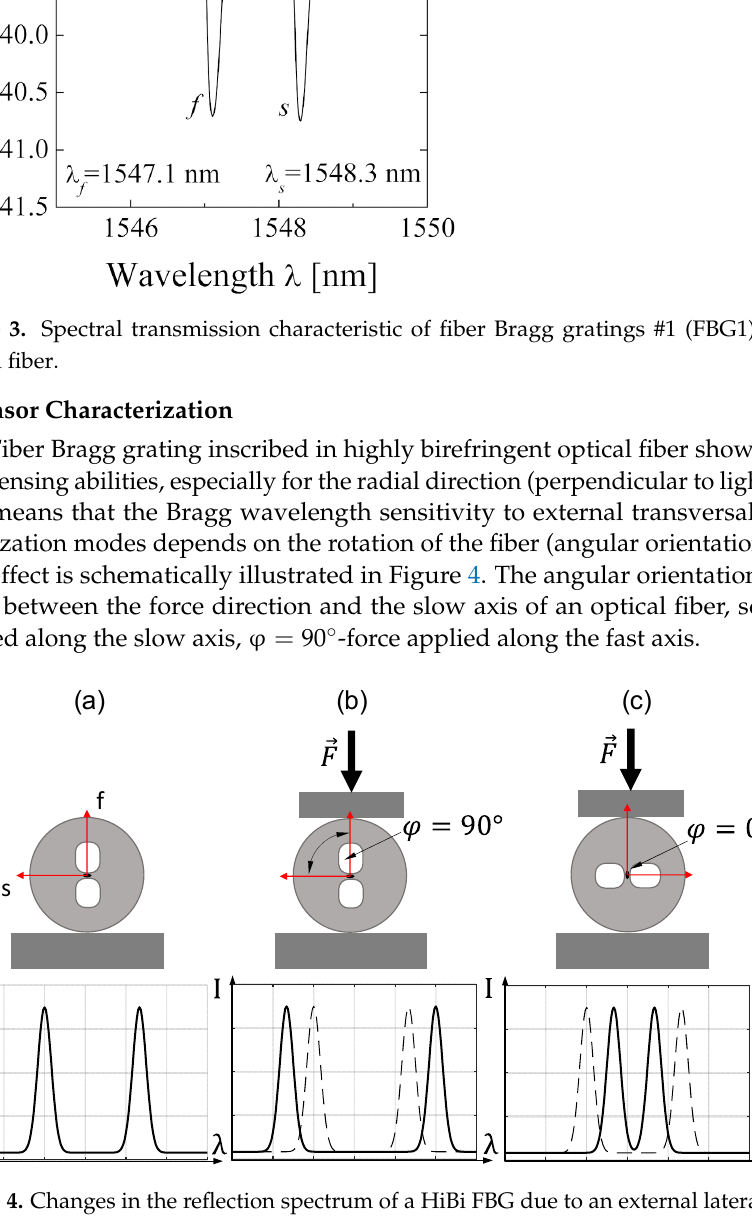
Figure 4. Changes in the reflection spectrum of a HiBi FBG due to an external lateral force along the main axes of the HiBi fiber ( ϕ —angular orientation of the fiber): no load applied ( a ), load applied along ( b ) fast axis and ( c ) slow axis of the side-hole fiber.